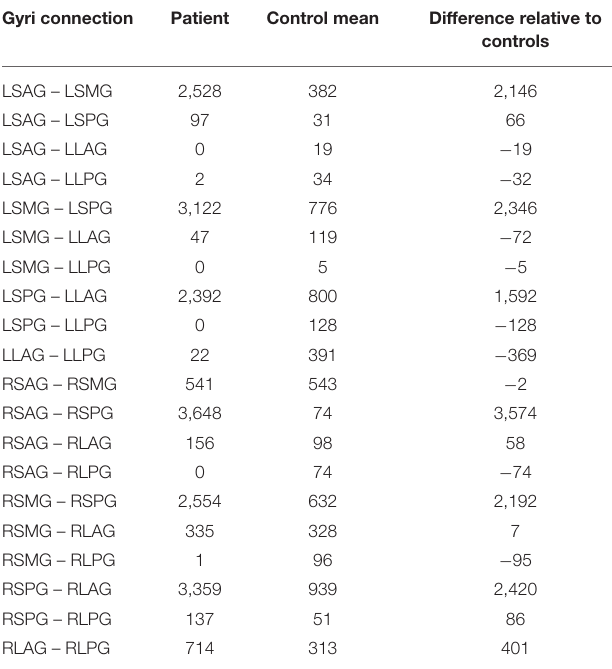
TABLE 5 | DTI tract counts between insula gyri for the patient, the mean of 3 controls and the calculated difference in the number of tracts. Gyri connection Patient Control